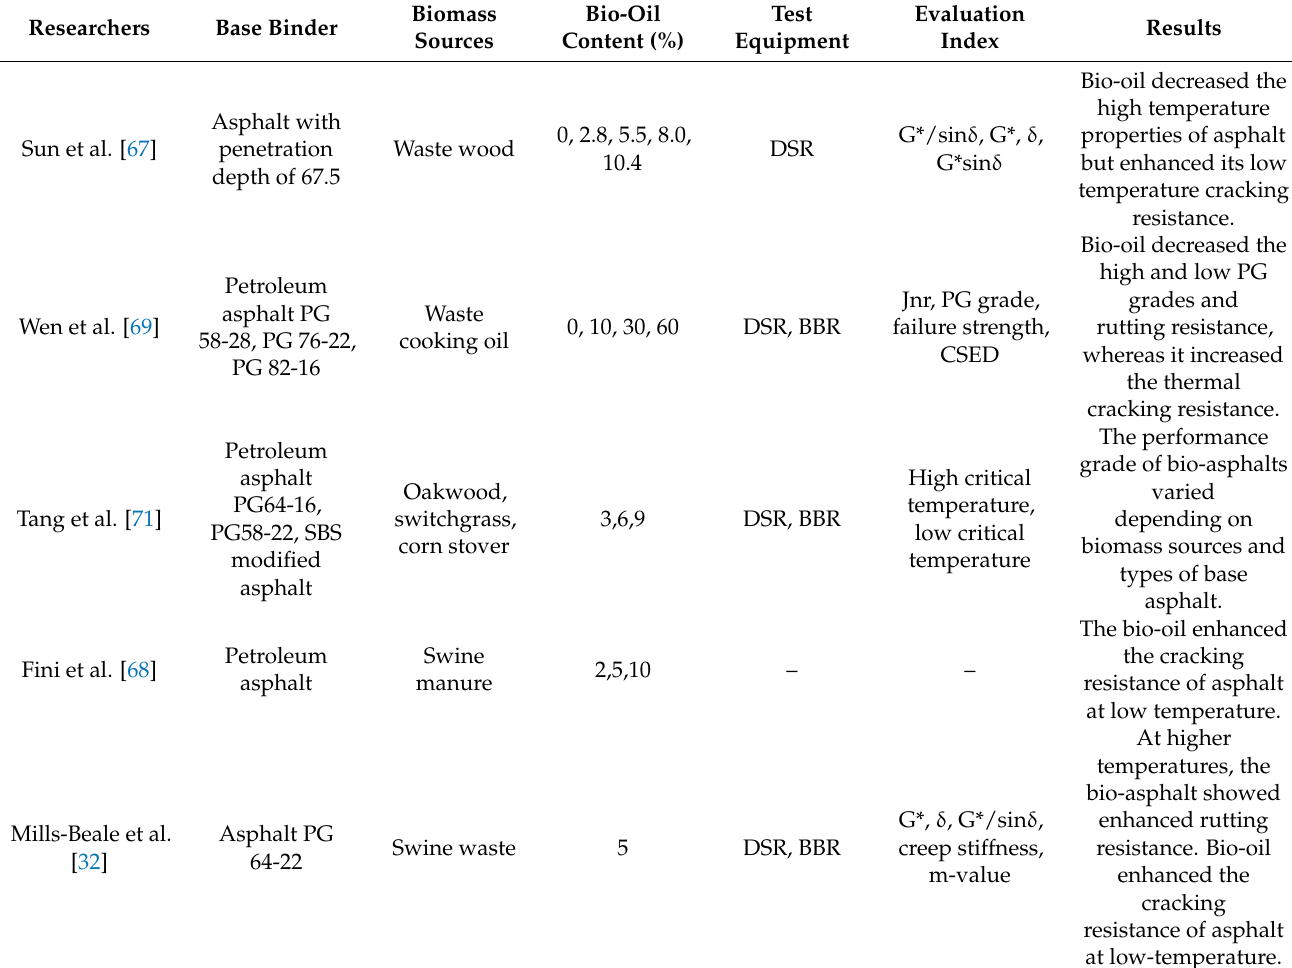
Table 7. Rutting, fatigue, and thermal cracking resistance of bio-oil modified